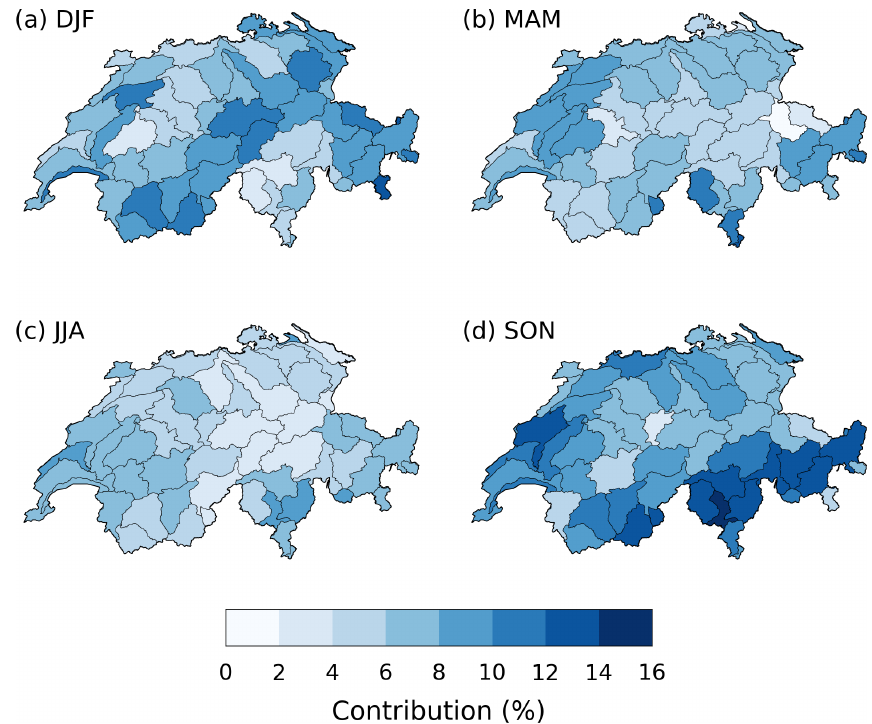
Figure 6. Contribution of 21d extreme precipitation clusters to seasonal precipitation in RhiresD, in (a) DJF, (b) MAM, (c) JJA and (d) SON.